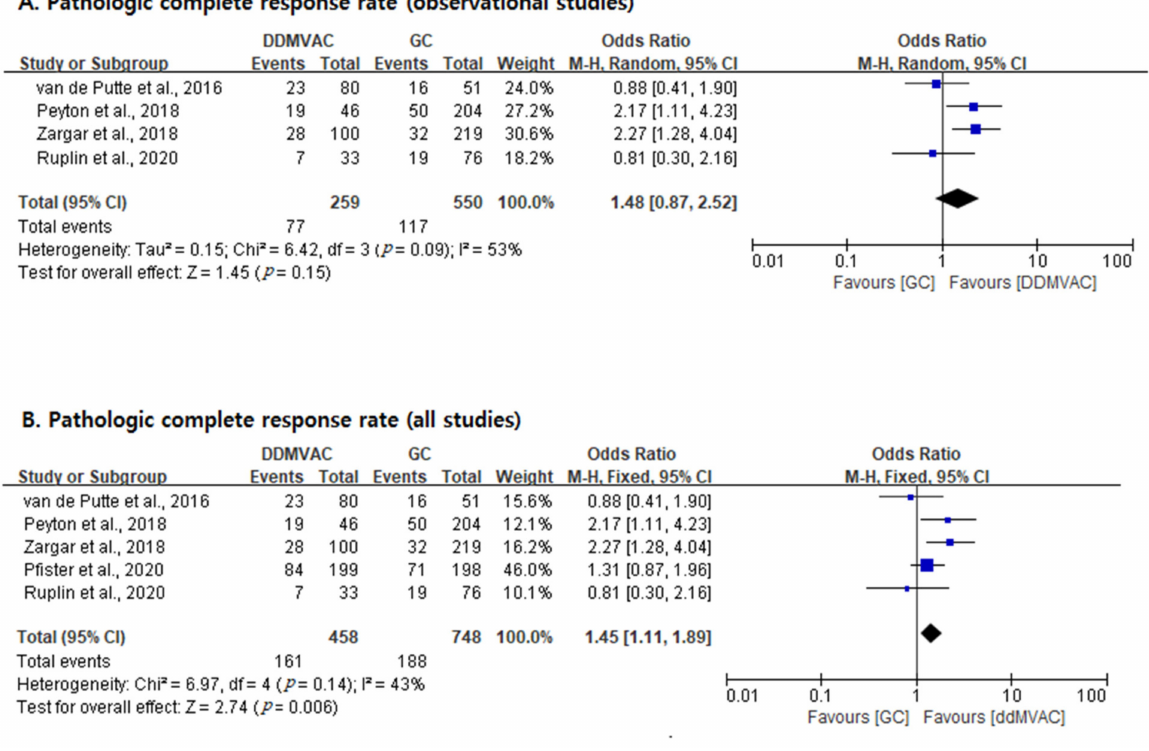
Figure 2. Forest plots of pathologic complete response rates. ( A ): Observational studies only. ( B ): All